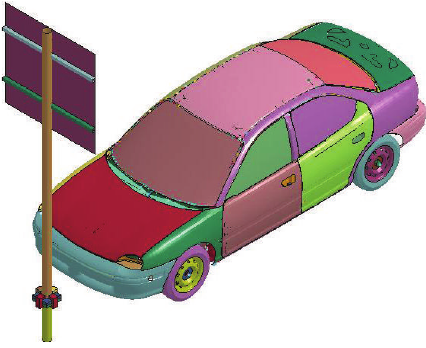
Figure9:Breakaway-typepostmodelusingshellandsolidelements.